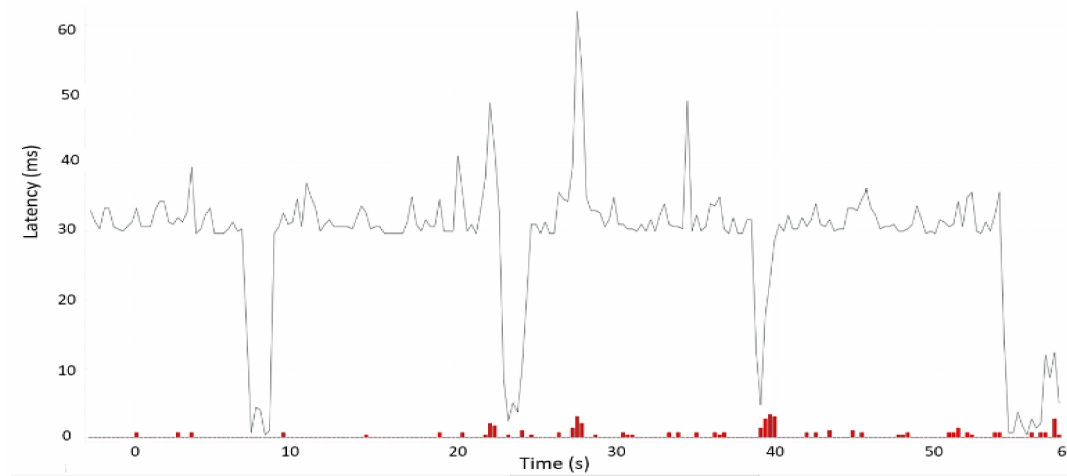
Figure 8. LTE latency.